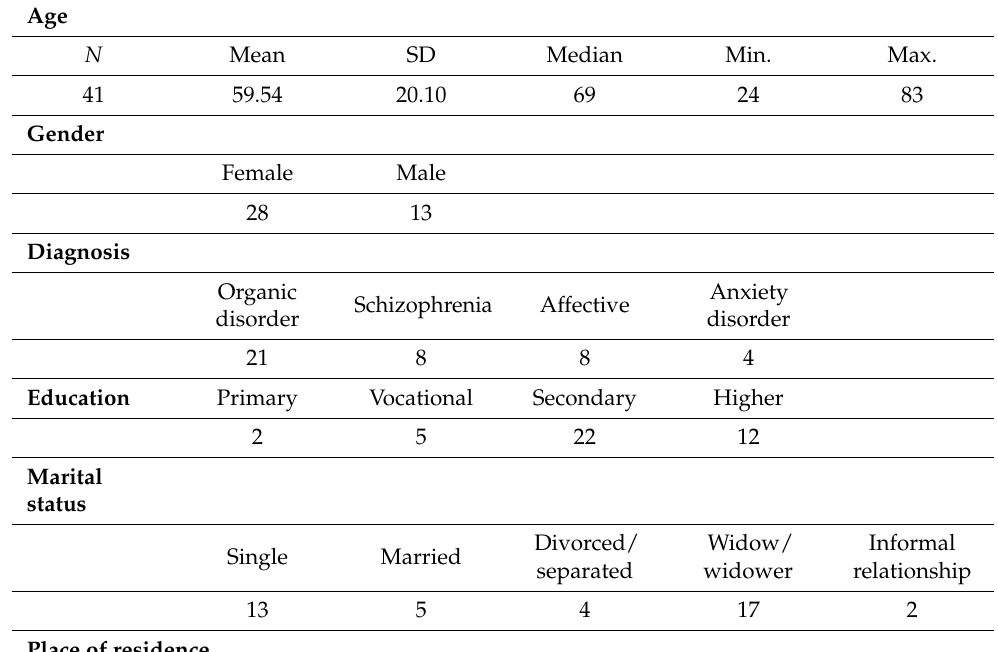
Table 3. Basic demographic characteristics of the study group ( N =